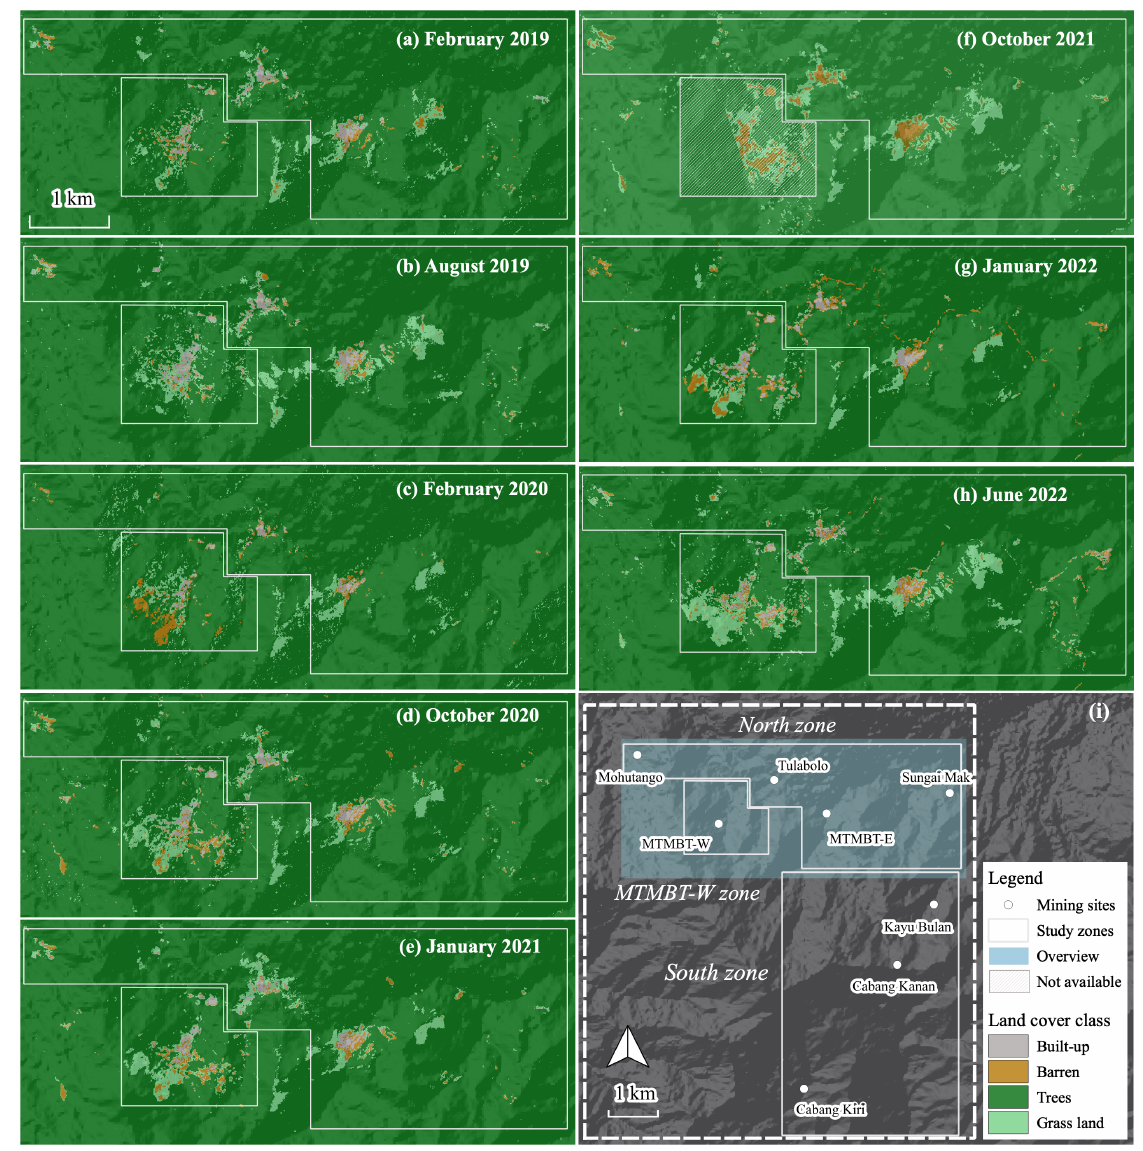
Figure 3. Landcover classification using PlanetScope series. ( a – h ) Landcover transformations in the north and Motomboto West zones (2019–2022); ( i ) overview of the target